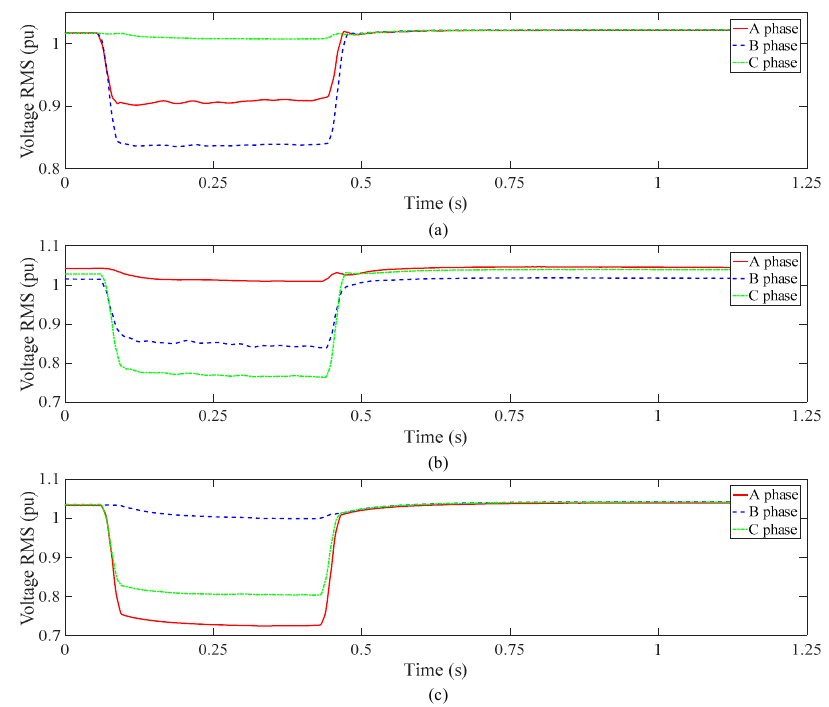
Figure 2. Typical waveforms of a two-phase short circuit. (a) Typical voltage RMS waveform of A- and B-phase short circuits; (b) typical voltage RMS waveform of B- and C-phase short circuits; (c) typical voltage RMS waveform of A- and C-phase short circuits.